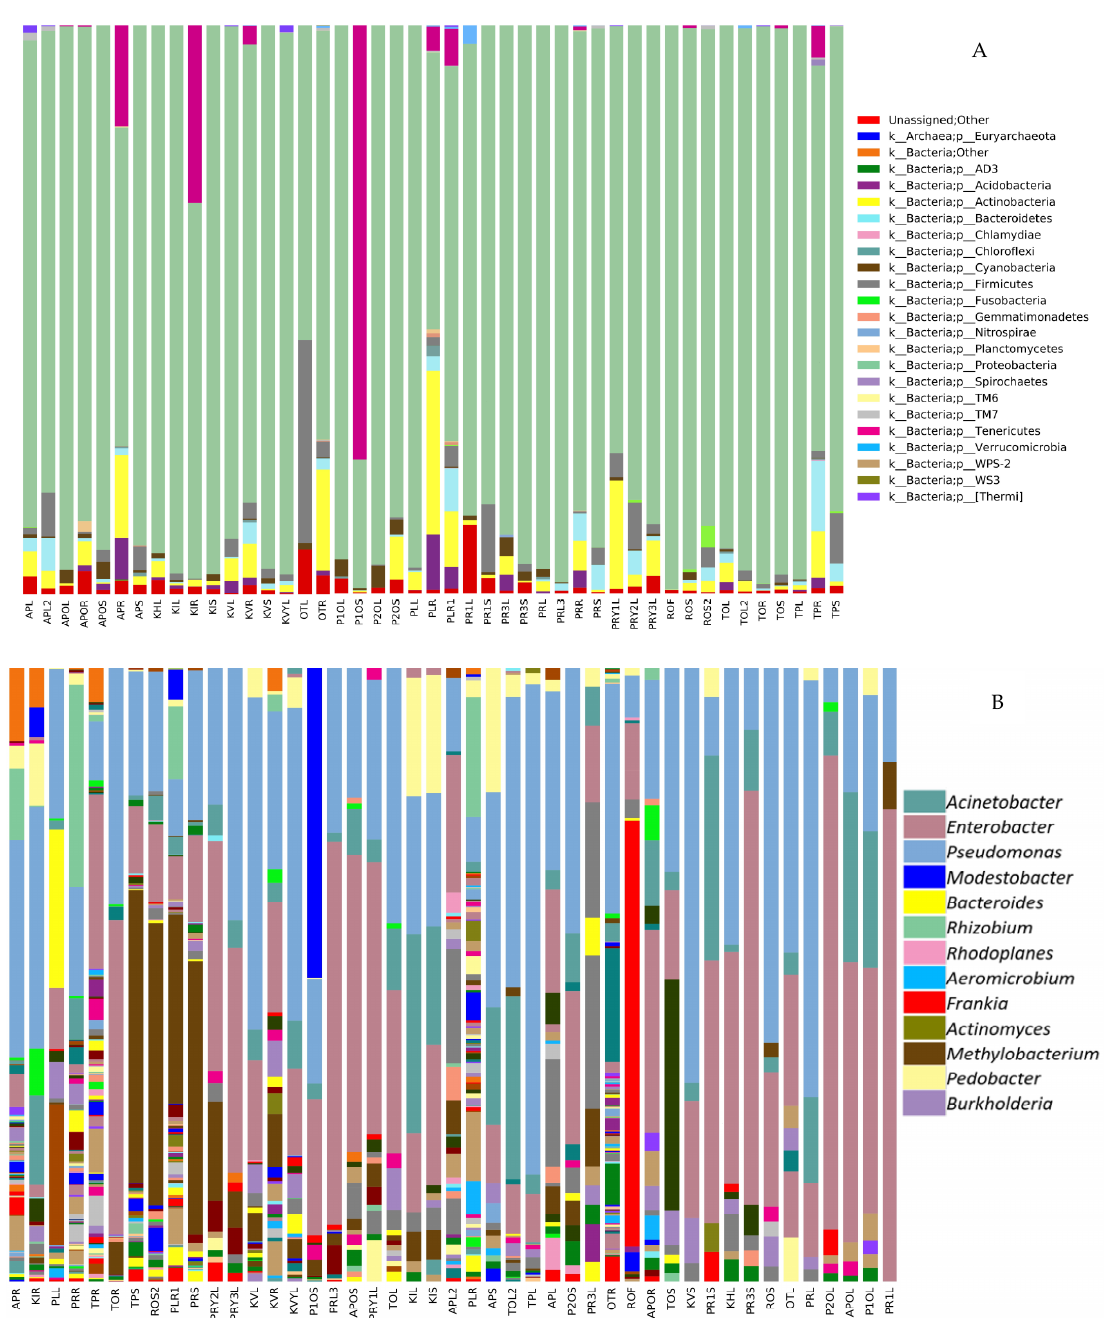
Figure 4. Bar charts showing community structure of endophytic bacteria in different plant tissues of Pseudowintera colorata as shown by Illumina MiSeq 16S rRNA amplicon sequencing at (A) the Phylum and (B) Genus level (showing the most dominant genera). Y-axis represents the samples.